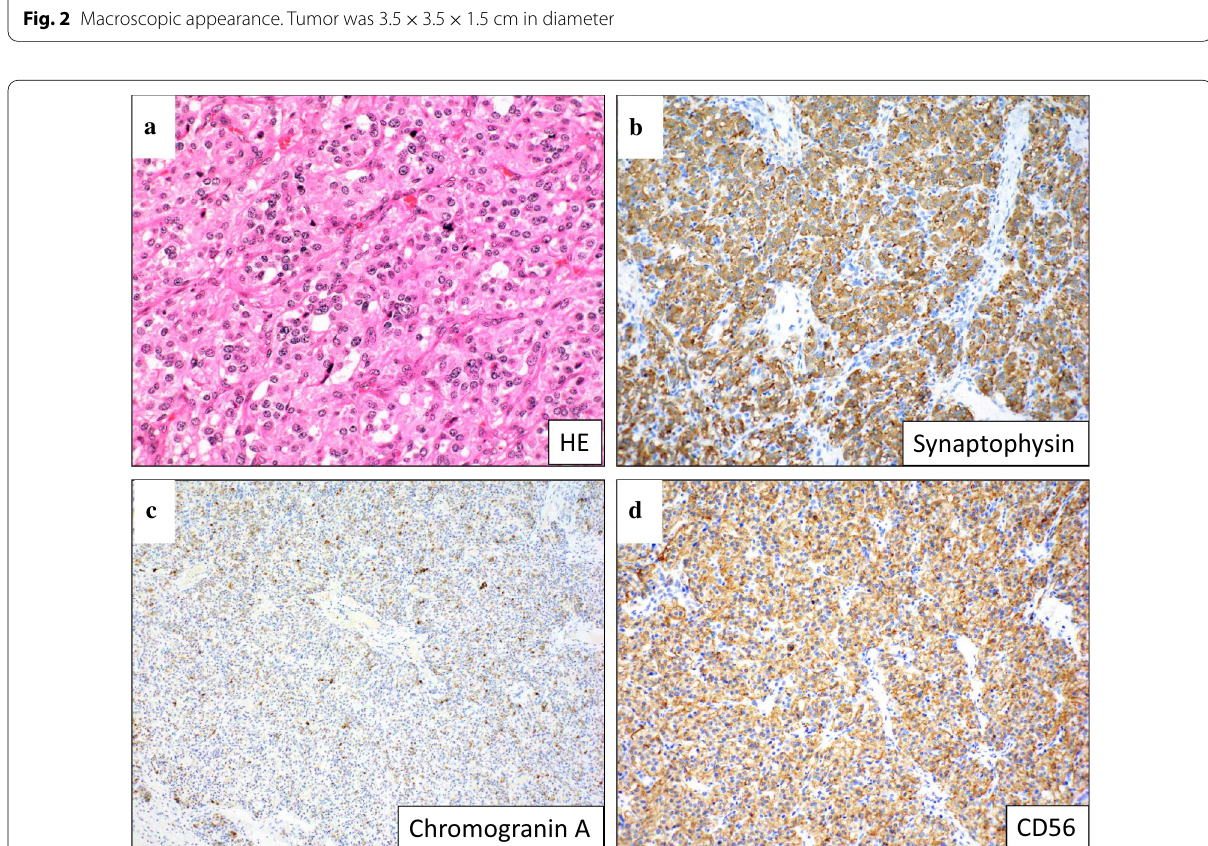
Fig. 3 Microscopic appearance. a Hematoxylin–eosin staining showed that the tumor cells, with clear cytoplasm, were arranged in nests ( b – d The tumor was immunoreactive for synaptophysin, chromogranin A, and CD56 protein, and was diagnosed as a paraganglioma arising in the middle mediastinum ( ×